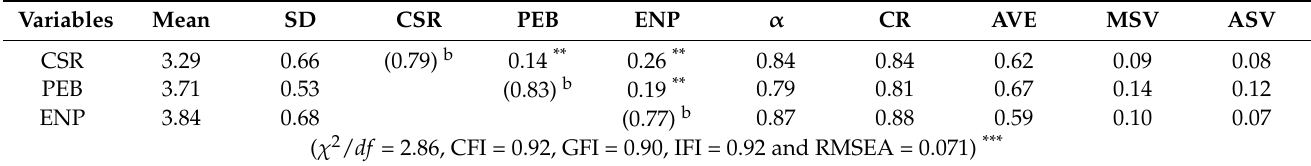
Table 2. Correlations, validities, and